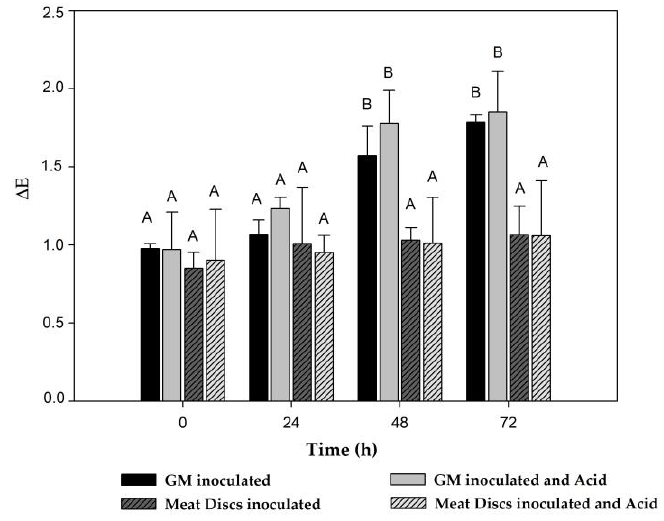
Figure 4. Comparison of total color differences (∆E) in ground meat (GM) and meat disc systems during storage time. Different letters represent significant difference p > 0.05. Black bars: GM inoc- ulated (ground meat inoculated with L. plantarum CRL681 + E. mundtii CRL35 and Escherichia coli NCTC12900); grey bars: GM inoculated and acid (ground meat inoculated with the addition of 0.6% lactic acid); gray dashed bars: meat discs inoculated (meat discs inoculated with L. plantarum CRL681 + E. mundtii CRL35 and Escherichia coli NCTC12900); white dashed bars: meat discs inocu- lated and acid (meat discs inoculated with the addition of 0.6% lactic acid).